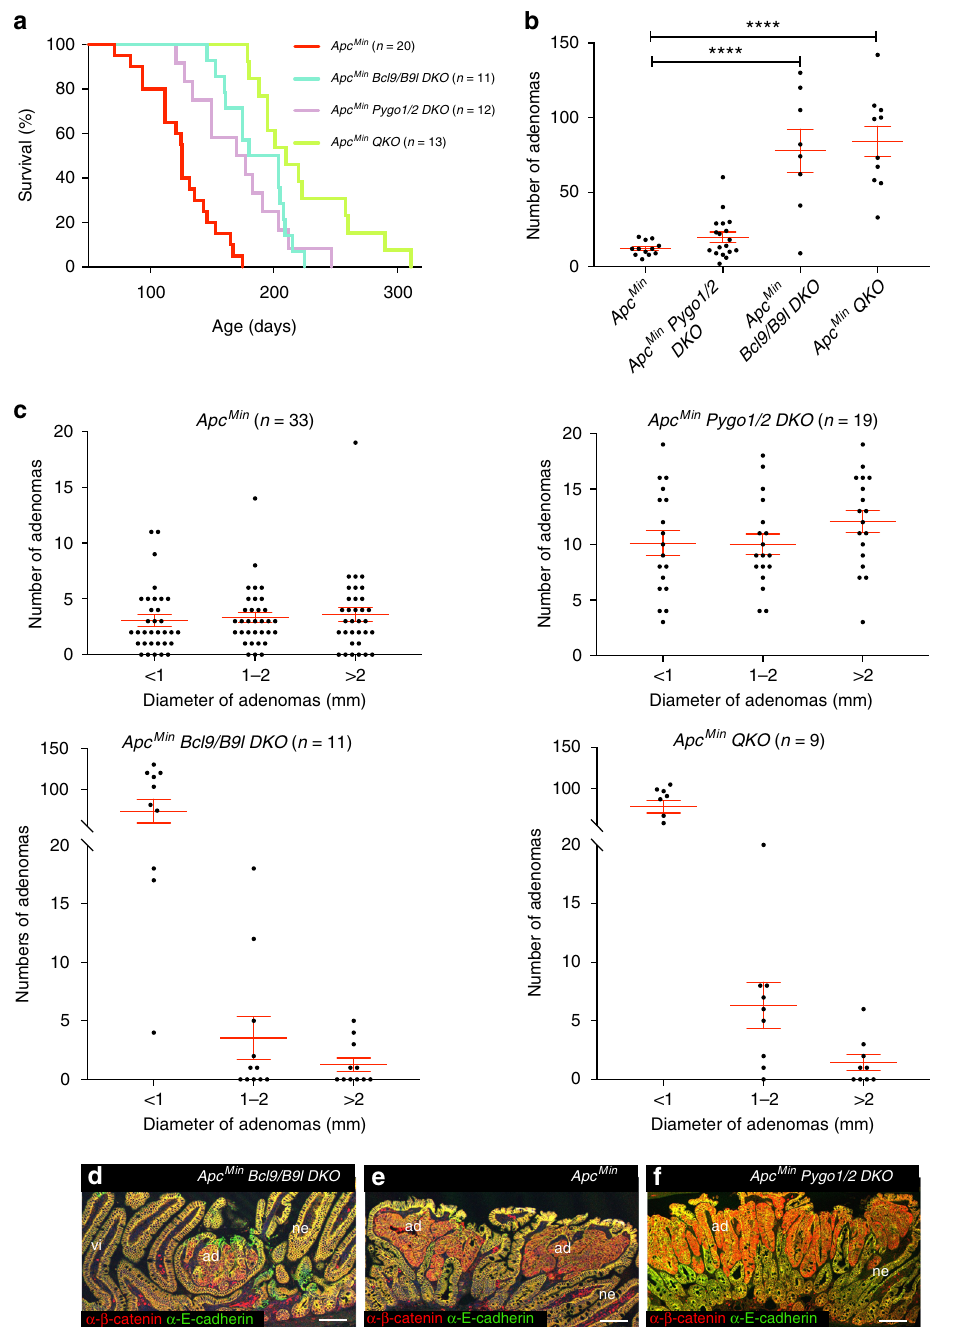
Fig. 1 Loss of Bcl9 and Pygo extends the disease-free live of Apc Min mice. a Kaplan – Meier survival plots of Apc Min DKO or QKO cohorts and matched Apc Min controls, as indicated on the right; statistical signi fi cance, p < 0.0001 (log-rank test). b Adenoma counts in small intestines from 120 day-old Apc Min DKO or QKO and matched Apc Min control mice, as indicated underneath graph; each dot represents one mouse; mean and SEM indicated by horizontal lines; ****, p < 0.0001 (Tukey ’ s multiple comparisons test). c Size distributions of adenomas shown in ( b ); tumours from each mouse (represented by dots) were grouped into three size classes, as indicated underneath graphs; lines as in ( b ). d – f IF of representative adenomas from Apc Min DKO and matched controls as indicated, after fi xation and double-staining with α - β -catenin ( red ) and α -E-cadherin ( green ) antibodies; QKO adenomas look similar to Bcl9/B9l DKO adenomas ( ad ), of which the majority ( > 95%) do not protrude above the villi ( vi ) and never progress to macroadenoma (unlike Pygo1/2 DKO and control adenomas); scale bar, 100 μ m. ne , normal epithelium. See also Supplementary Figures 1 –